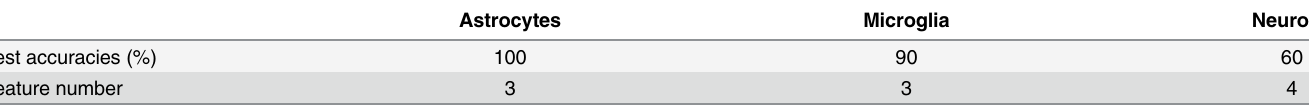
Table 7. Prediction accuracies on the 10 gabapentin co-infused rats.